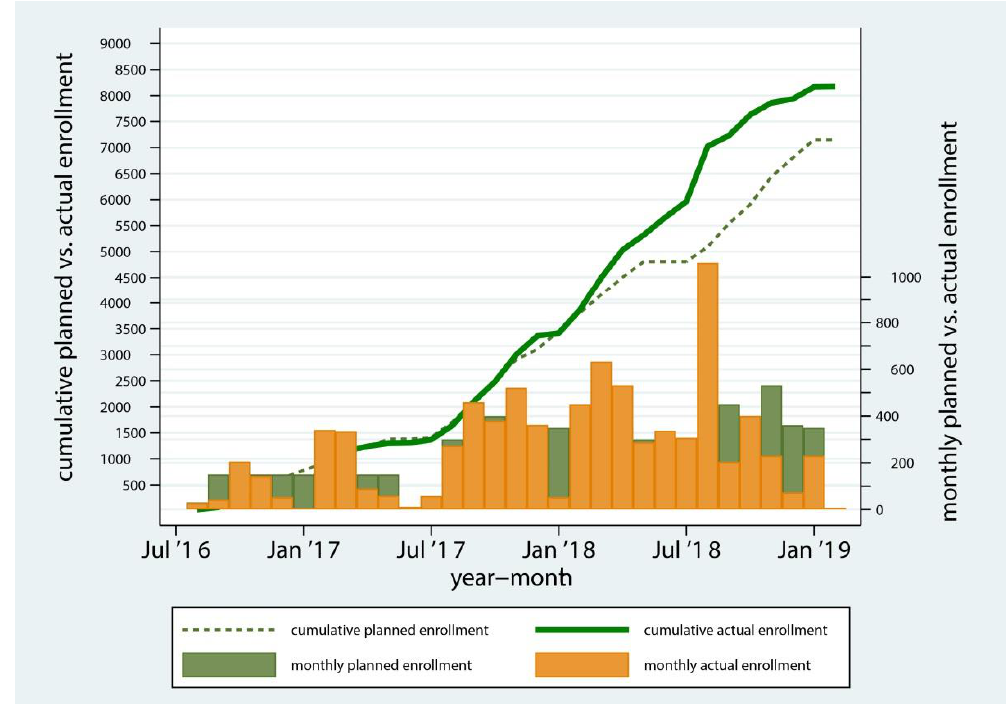
Figure 3. Monthly and cumulative enrollment during the 30-month enrollment period in the ZOE 2.0 study, North Carolina, United States.